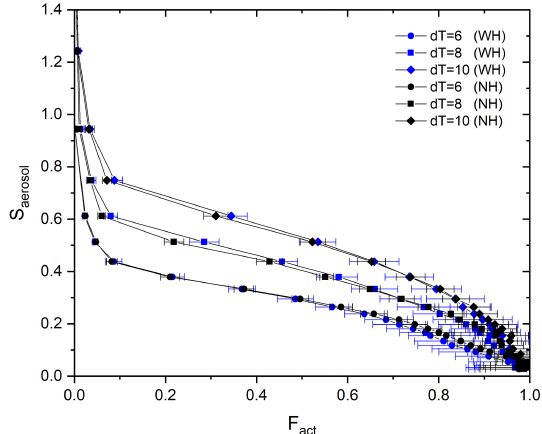
Figure 7. Calibration curves ( F act − S aerosol ) for three different T gradients: d T = 6 (circle), 8 (square), and 10K (diamond) with a humidifier system (WH) and without a humidifier system (NH).